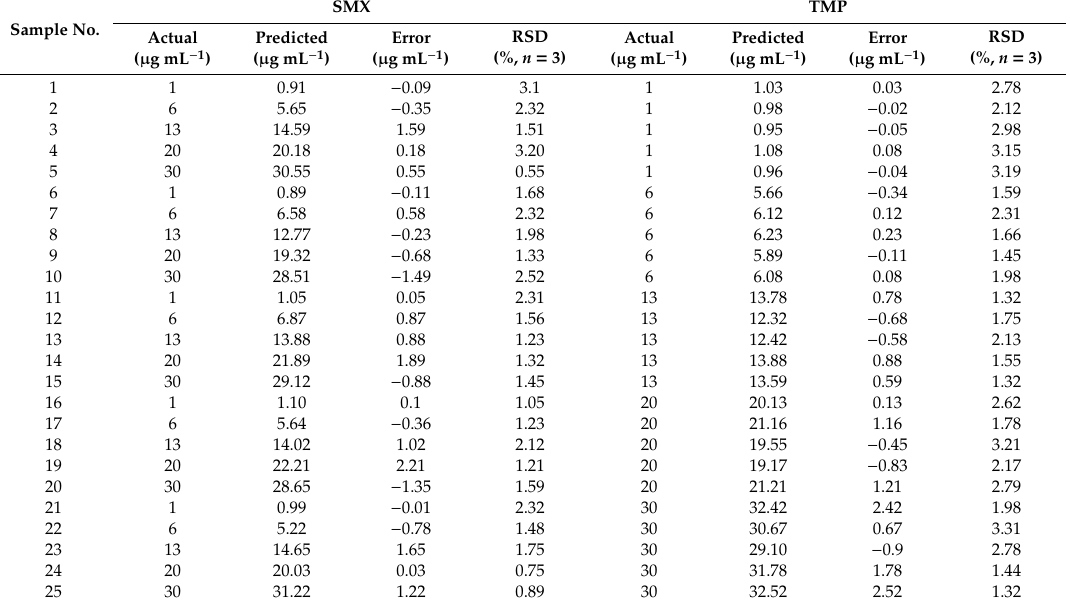
Table 2. The concentrations of SMX and TMP and the results of the replicate measurements for determination of SMX and TMP in synthetic